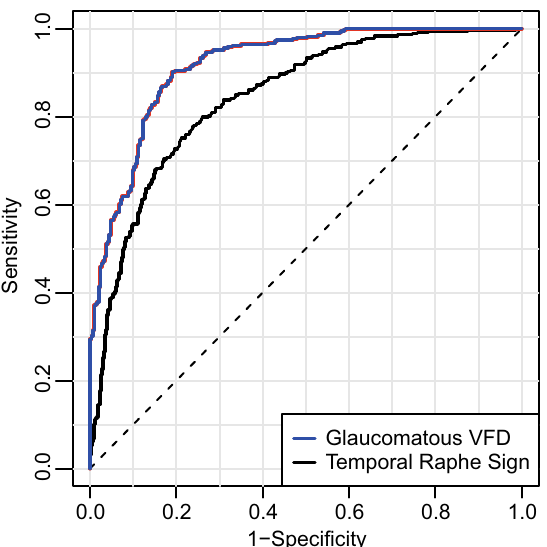
Figure 4. Receiver operating characteristic curve showing HDLM’s discriminating ability for glaucomatous visual field loss and temporal raphe sign. The temporal raphe sign, a step-like configuration near the temporal raphe on an HD-OCT mGCIPL thickness map, reflects the ST-IT mGCIPL asymmetry. The AUC of the HDLM’s determinations of glaucomatous VFD and temporal raphe sign positivity were 0.918 and 0.843, respectively. (HDLM = hybrid deep learning model; ST = superotemporal; IT = inferotemporal; mGCIPL = macular ganglion cell-inner plexiform layer; AUC = area under curve; VFD = visual field